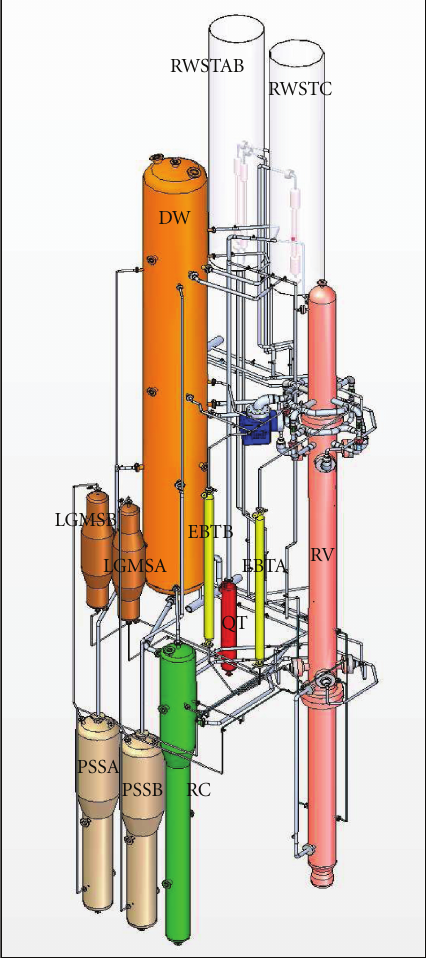
Figure 4: SPES3 general view.